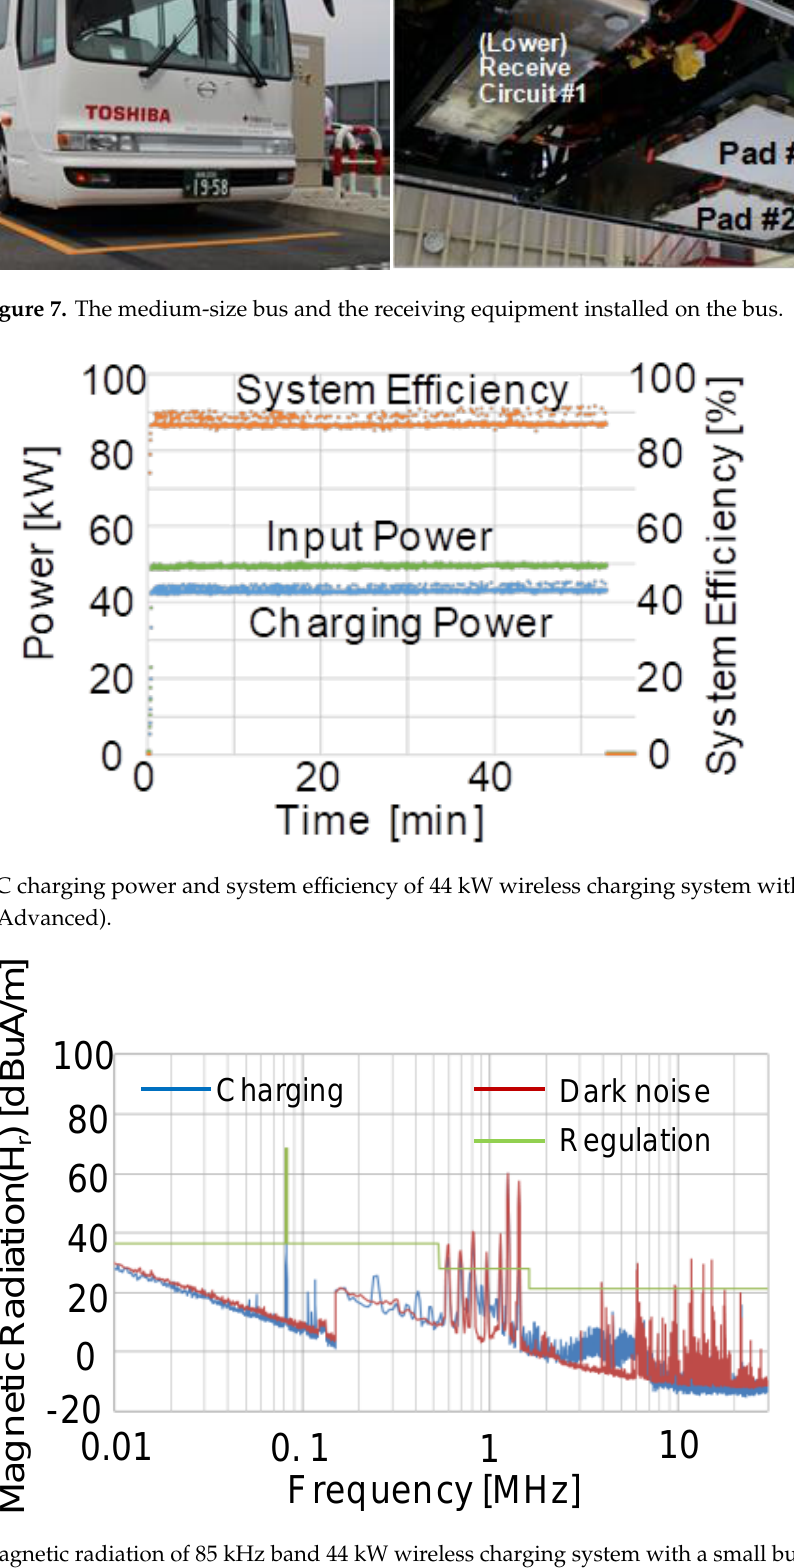
Figure 9. Magnetic radiation of 85 kHz band 44 kW wireless charging system with a small bus (WEB3 Advanced) at a distance of 10 m